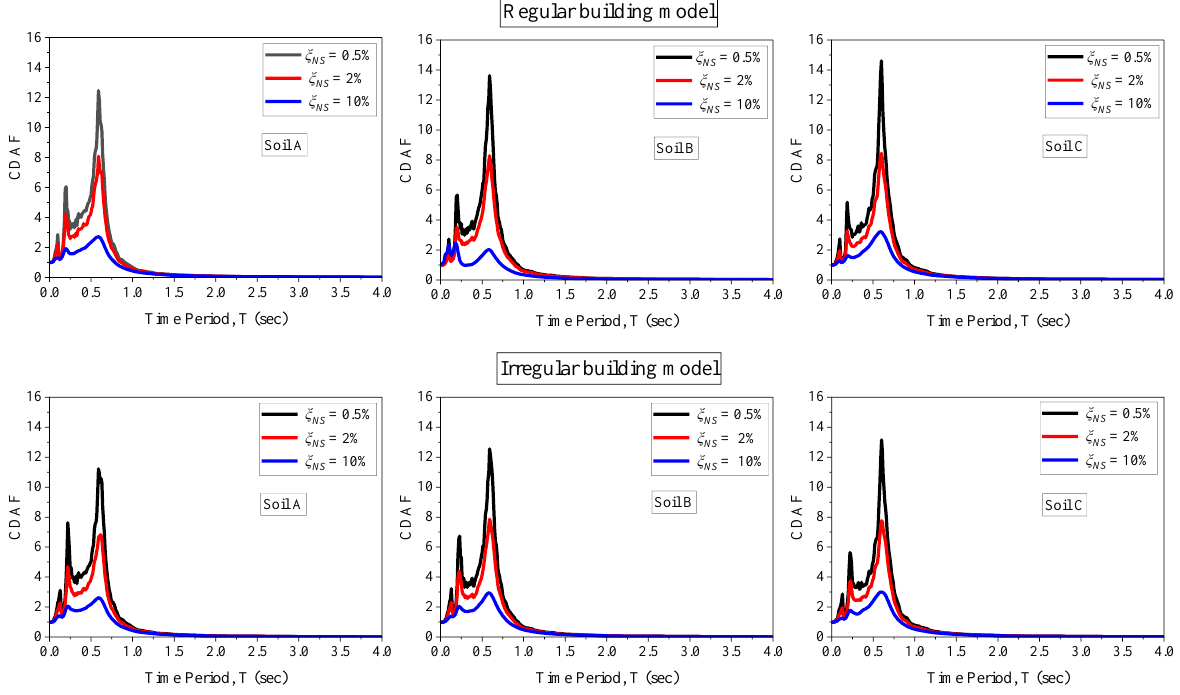
Figure 14. CDAF spectrum for a top floor at various damping ratios of NSC.